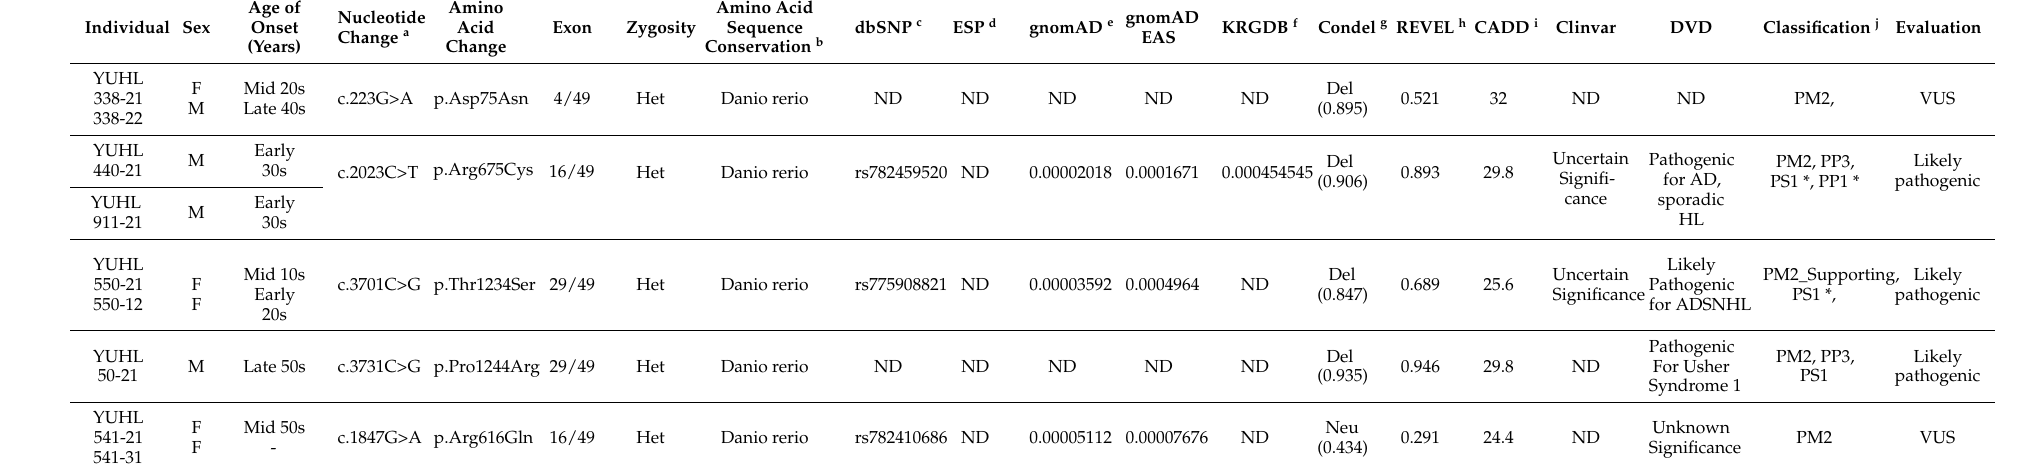
Table 1. Variants in MYO7A identified in individuals with autosomal dominant hearing loss by exome